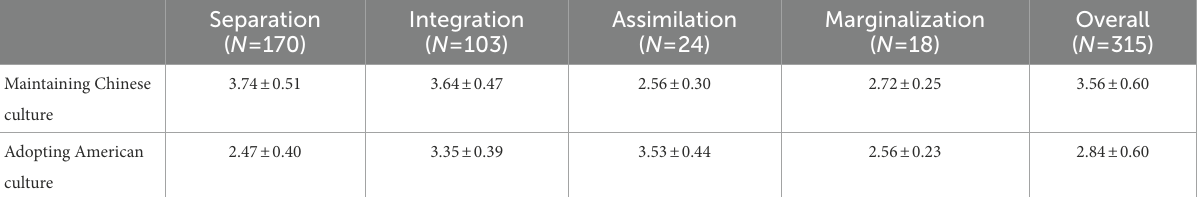
TABLE 3 Acculturation strategies among Chinese students [M ±